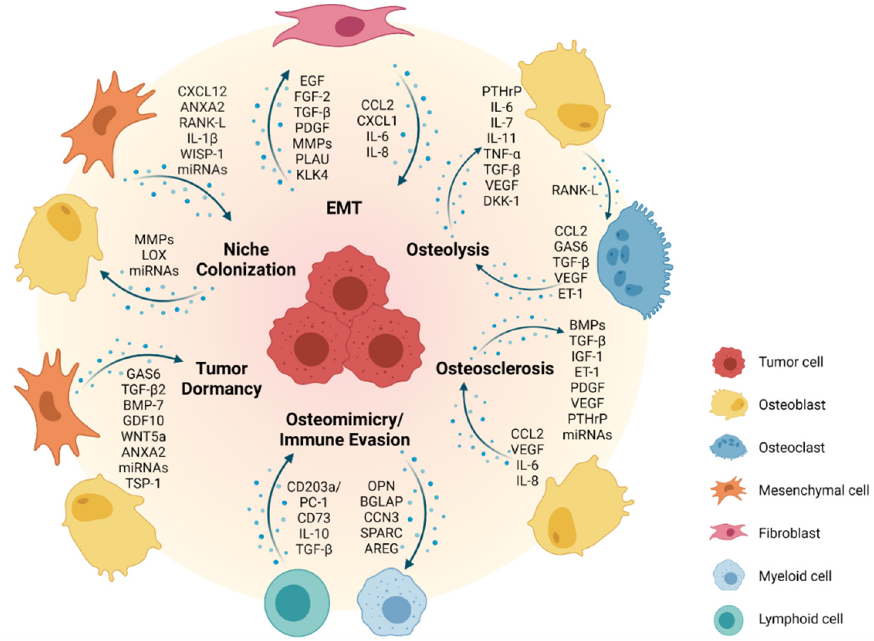
Figure 1. Tumor–microenvironment interactions in bone metastasis. The bone metastatic process involves several steps, including epithelial-to-mesenchymal transition (EMT), colonization of the metastatic niche, tumor dormancy, immune evasion/osteomimicry, bone reconstruction and progression to overt metastases. At later stages, tumor cells secrete factors that stimulate osteoclasts or osteoblasts, leading to excessive bone loss (osteolysis) or bone formation (osteosclerosis), respectively. Most solid tumor metastases to bone exhibit a mixed phenotype of osteolytic and osteoblastic lesions. Highlighted are several key factors that are released by tumor cells and various cell types of the bone metastatic niche mutually controlling their metastasis-driving activities. Created with BioRender.com (accessed on 27 August